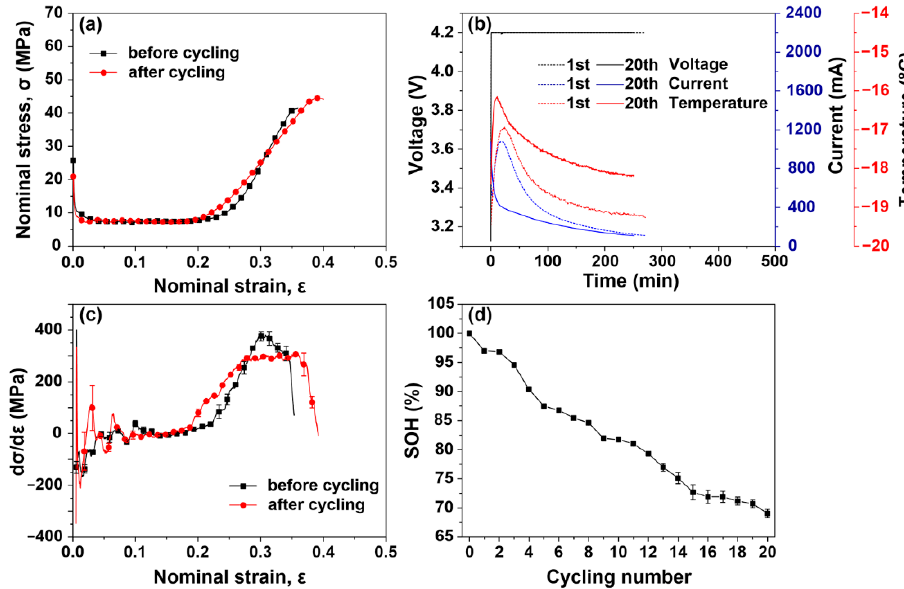
Figure 10. ( a ) Nominal stress–strain curves, ( b ) voltage–time, current–time and surface temperature–time curves, and ( c ) nominal modulus–strain curves of the 18650 lithium-ion battery cells before and after cycling at − 20 °C and 0.5 C. ( d ) The SOH of the cells during the cycling. Table 2. Actual charge capacity and average ohmic resistance of charged 18650 LIB cells in the first and 20th cycles. Actual Charge Capacity Cycling Number